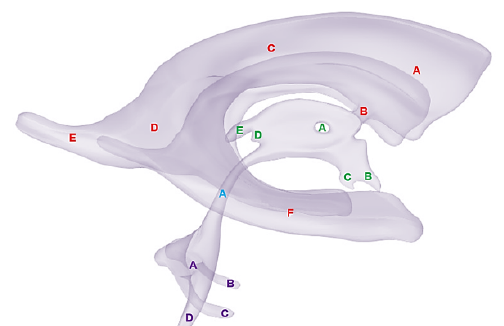
Fig. 4. The ventricular system in right lateral view. Lateral ventricle (in red): frontal horn (A), foramen of Monro (B), body (C), atrium (D), occipital horn (E), temporal horn (F). Third ventricle (in green): interthalamic adhesion (A), optic recess (B), infundibular recess (C), pineal recess (D), suprapineal recess (E). Cerebral aqueduct (in blue) (A). Fourth ventricle (in purple): fourth ventricle (A); left lateral recess and left lateral aperture of Luschka (B), right lateral recess and right lateral aperture of Luschka (C), median aperture of Magendie